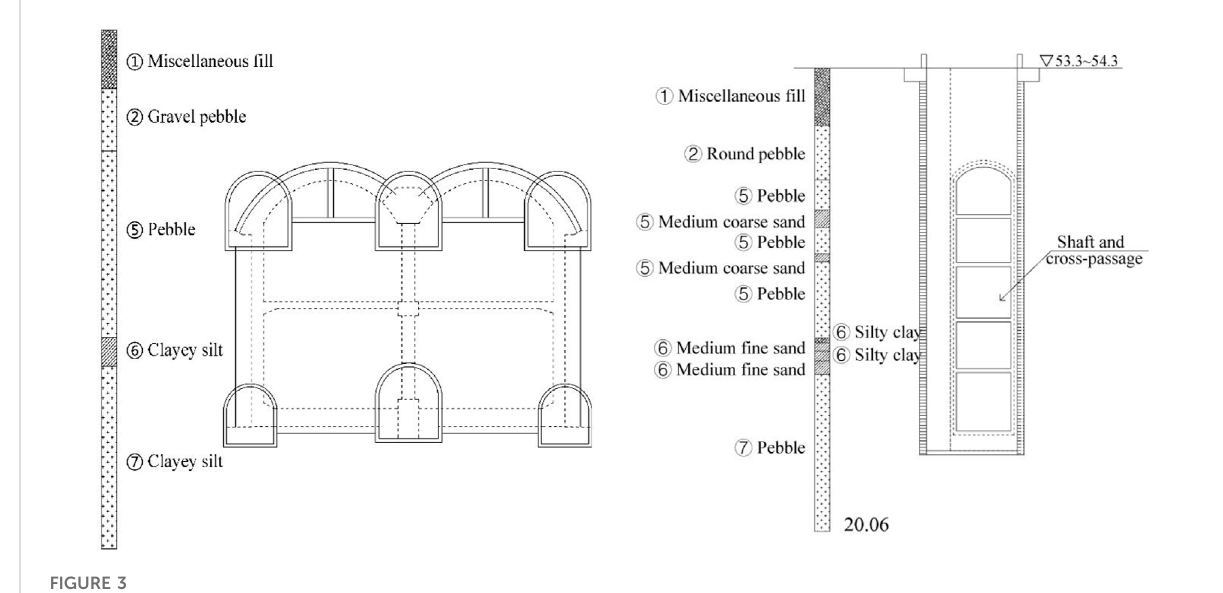
FIGURE 3 Geological condition of Sijiqing Station, shaft, and cross passage.